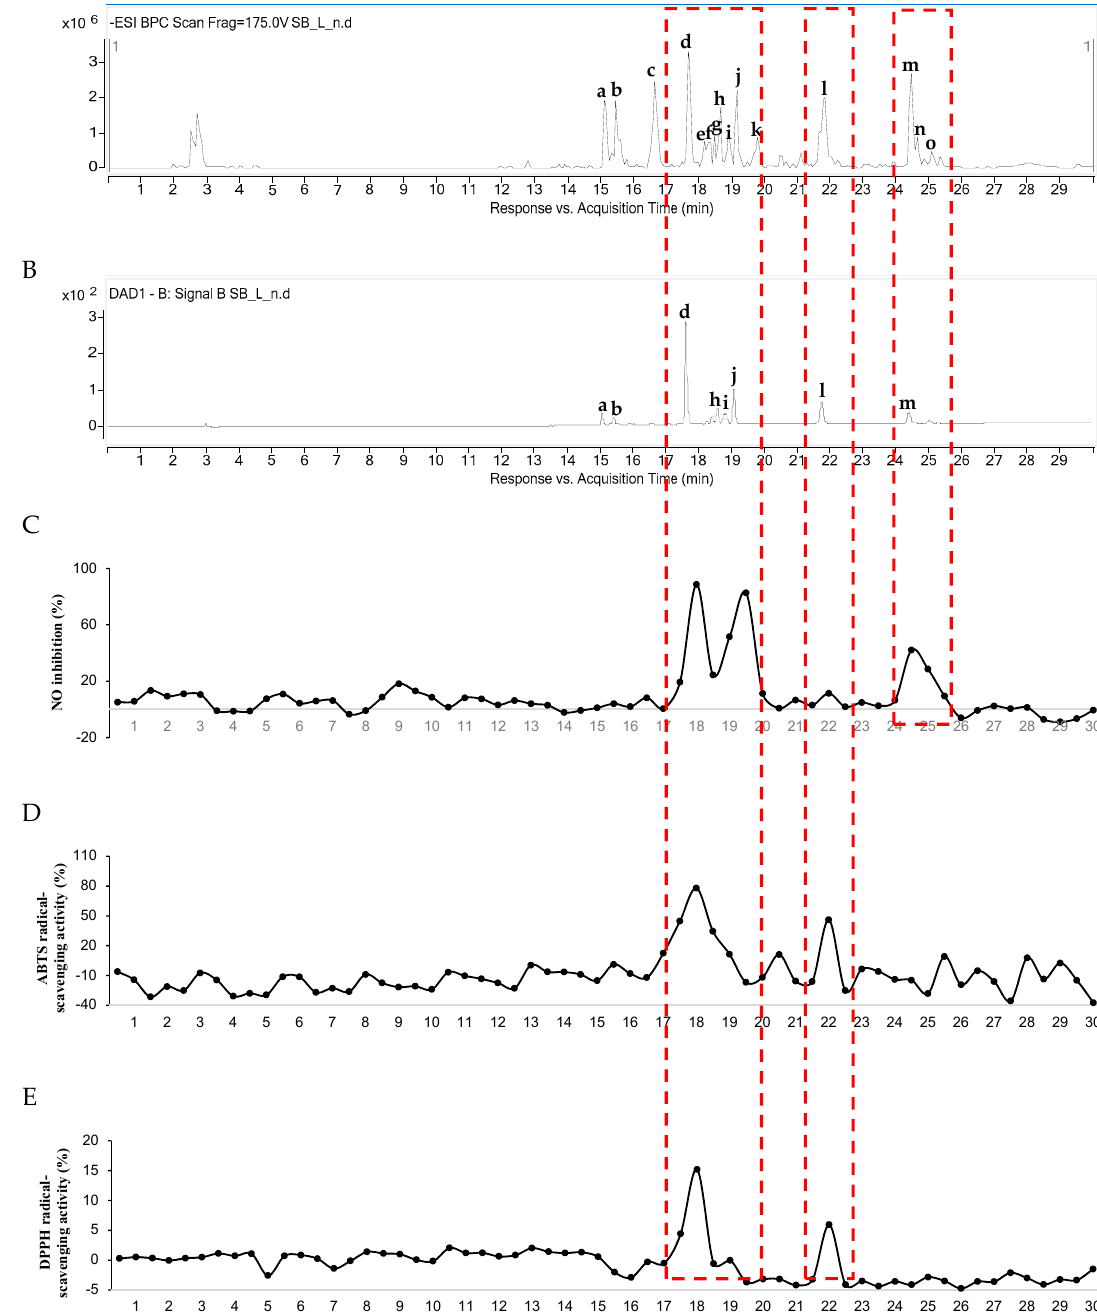
Figure 1. LC-QTOF MS / MS coupled with bioassay. ( A ) ESI-MS chromatogram (negative ionization mode); ( B ) UV chromatogram (254 nm); ( C ) NO production inhibitory activity of each 30 s intervals eluent; ( D ) ABTS free radical-scavenging activity of each 30 s intervals eluent; ( E ) DPPH free radical-scavenging activity of each 30 s intervals eluent of MeOH extract of S. baicalensis.